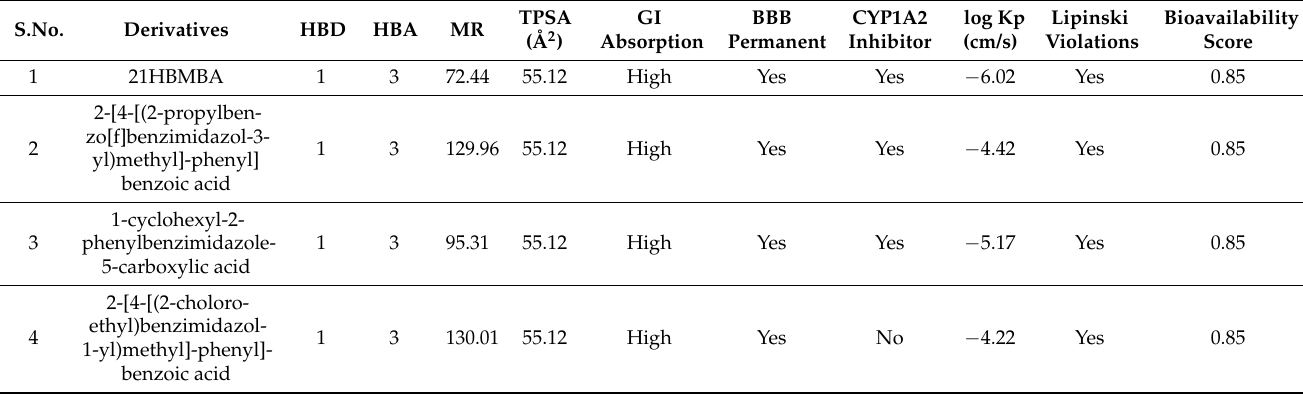
Table 8. ADME characteristics of 21HBMBA and its derivatives.